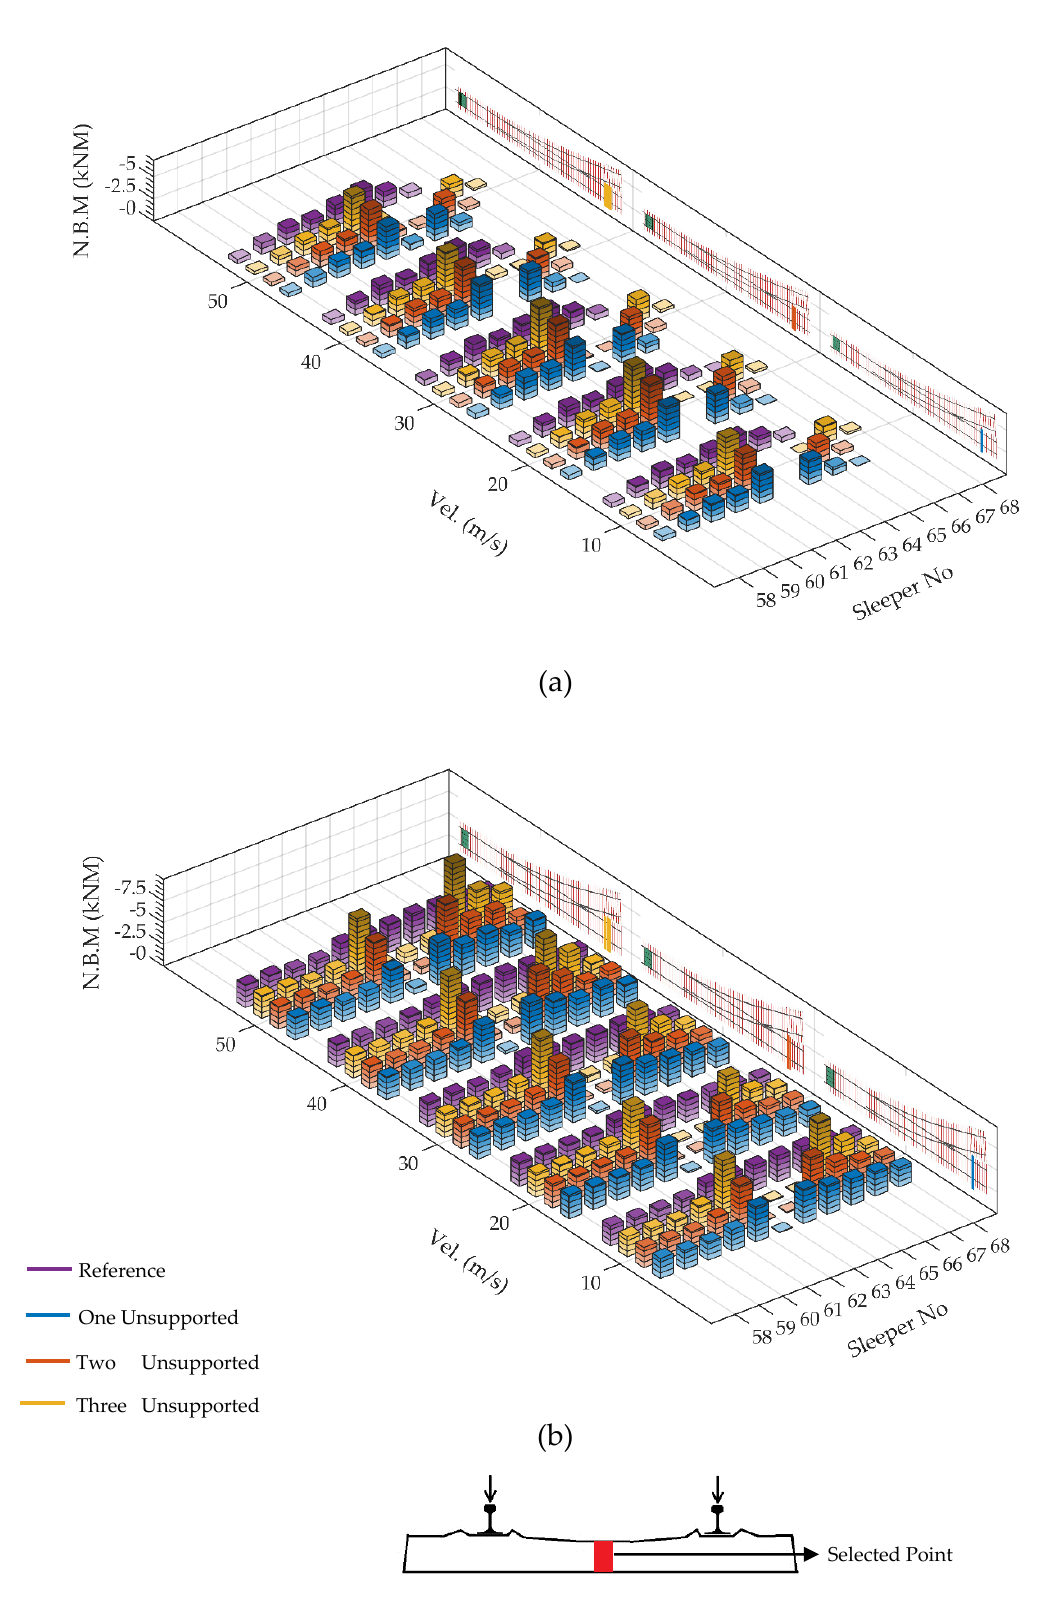
Figure 21. The distribution of negative bending moments over the bearers when the shortest bearer is unsupported: ( a ) at particular time when the front wheel is on the bearer with number 62; ( b ) when maximum occurs at each bearer.